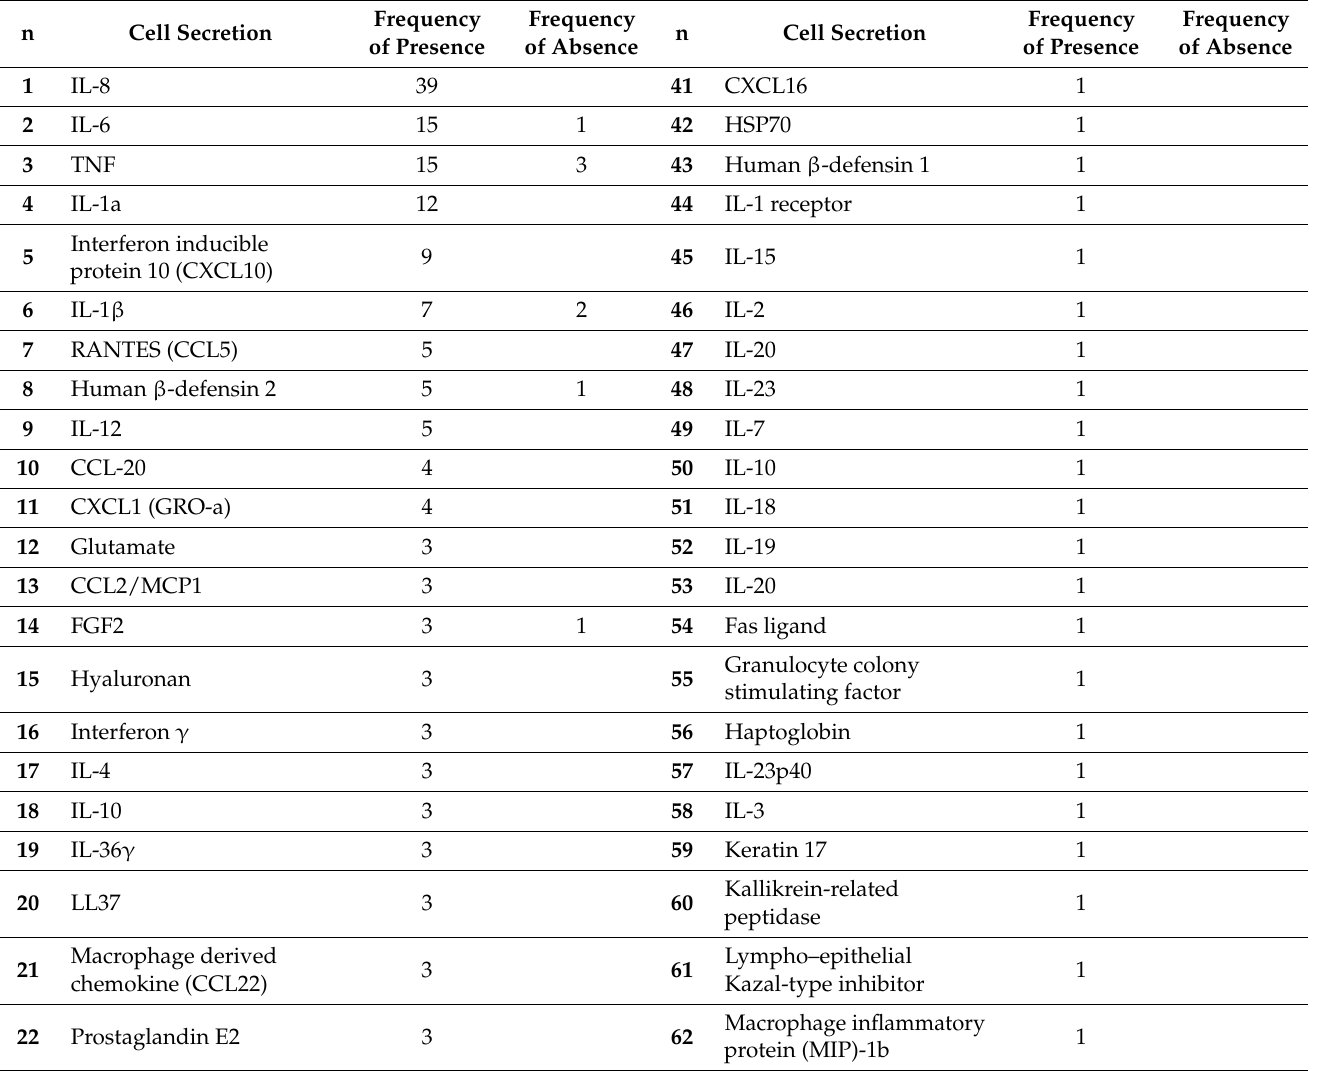
Table 1. The frequency of the reported presence or absence of secretions in cell culture